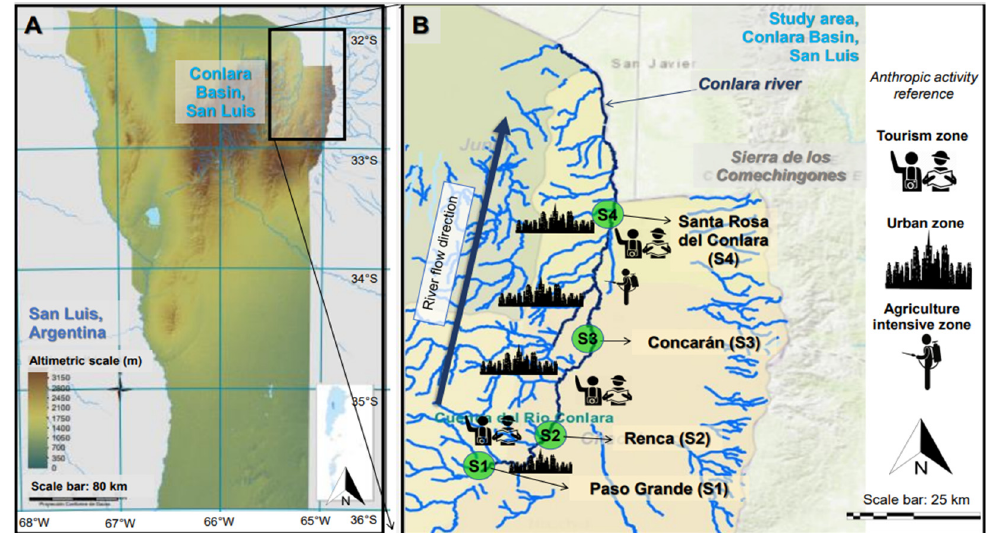
Figure 1. Map of San Luis Province, Argentina ( A ) showing in detail ( B ) the four study sites (S1–S4) at the Conlara River and the nearby anthropic activities within the Conlara basin from San Luis, Argentina. The studied Conlara River is represented with a dark blue color within the Conlara basin. The legend of the iconographies is on the right of ( B ).